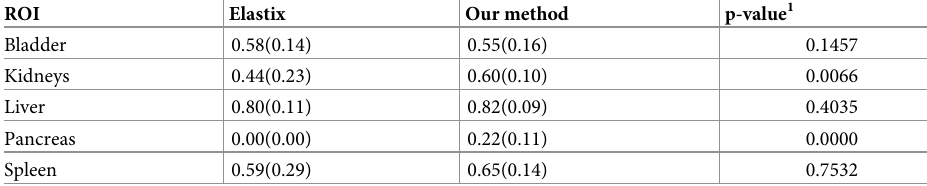
Table 1. Mean and standard deviation of the S ø rensen–Dice coefficient for the overlapping of segmented ROIs in the comparative